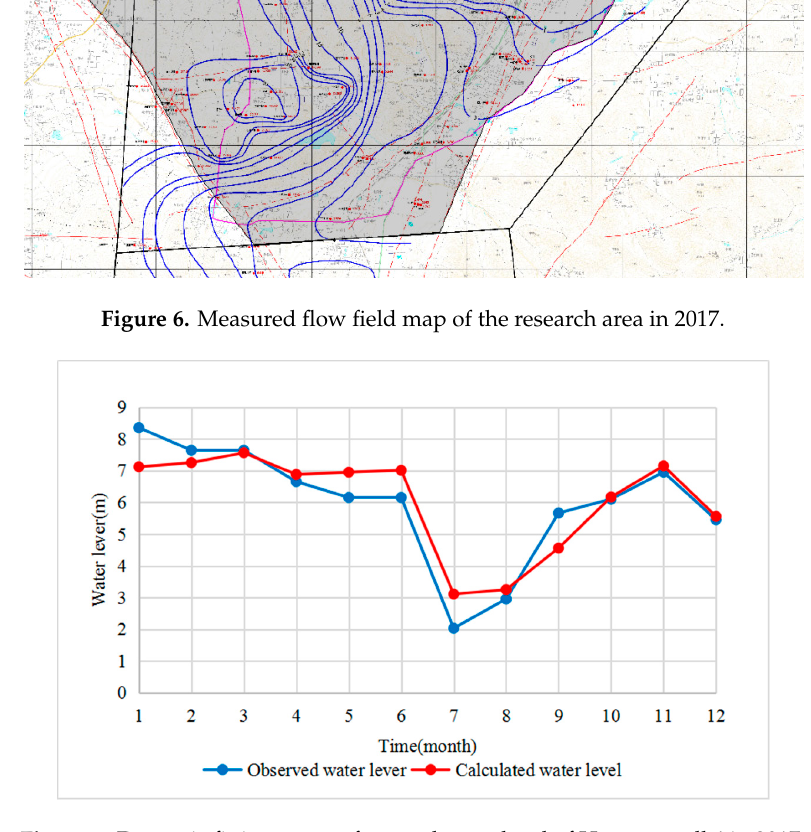
Figure 7. Dynamic fitting curve of groundwater level of Hougao well 4 in 2017.